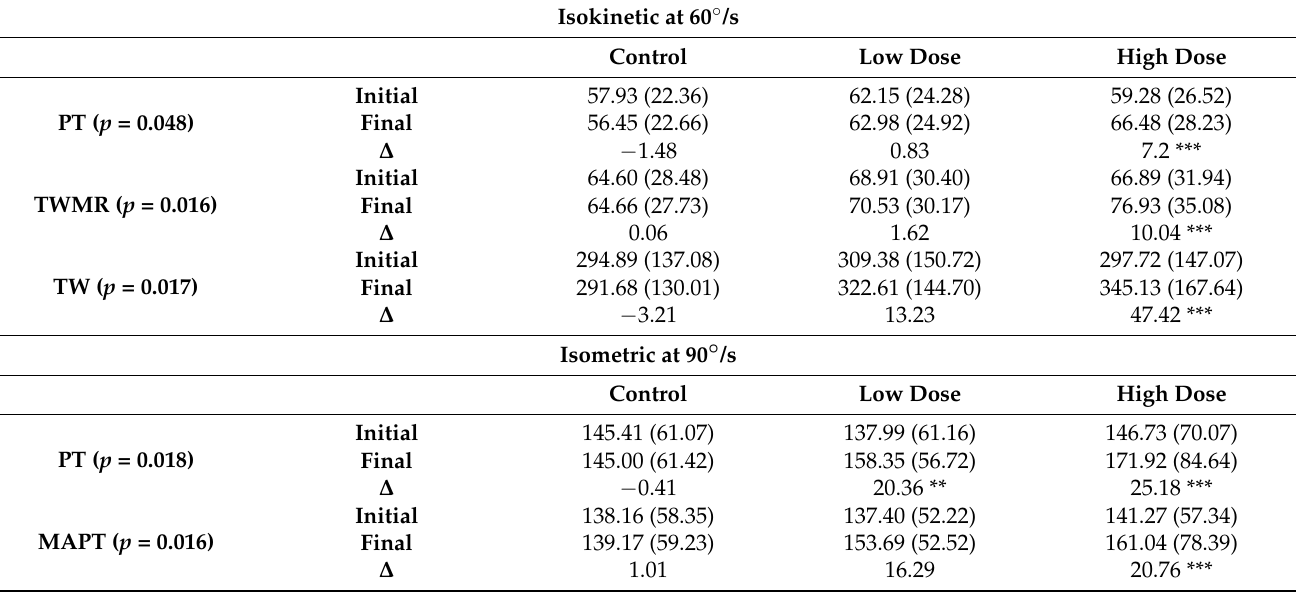
Table 4. Isokinetic trials variables at 60 ◦ /s: muscle peak torque (PT), total work of the maximum repetition (TWMR), and total work (TW). Isometric trials assessed at 90 ◦ /s: muscle peak torque (PT) and maximum average peak torque (MAPT). ∆ represents the increment from the start to the end of this trial. Significance level for the differences between values at the beginning and end of this trial. p values indicate significance level for comparison of groups by the duration of this trial for each variable. Units were measured in N ×